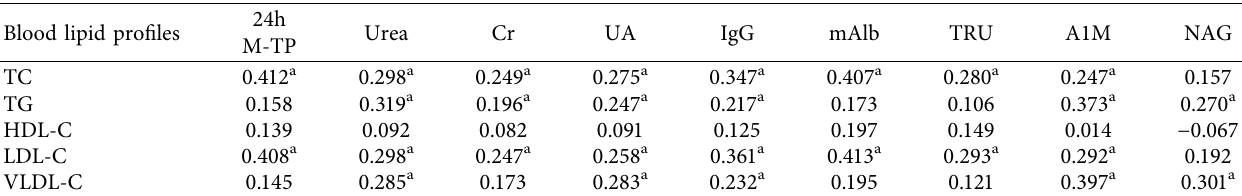
Figure 1: ROC curve analysis of the use of blood lipid profiles for diagnosis of LN. Abbreviations: TC: total cholesterol; TG: triglyceride; LDL-C: low-density lipoprotein cholesterol; VLDL-C: very low-density lipoprotein cholesterol. Table 3: Relationships between blood lipid profiles and renal function indicators in children with LN.